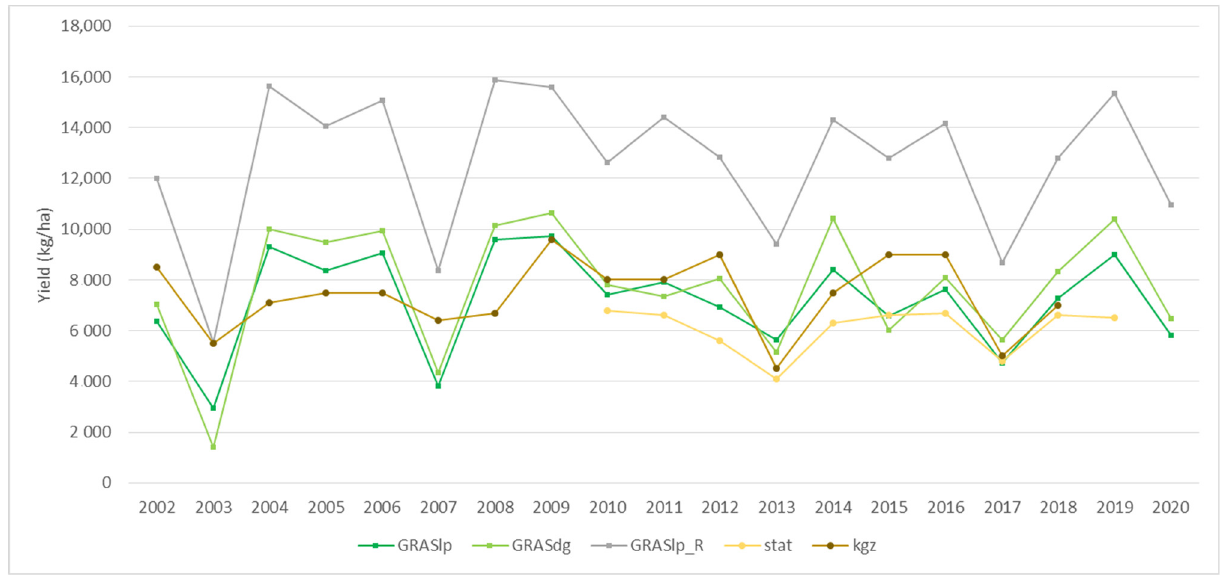
Figure 5. Model results of annual grassland yield for Farm2 using the parameter set calibrated for Dactylis glomerata and Lolium perenne in Jablje (GRASdg and GRASlp), Lolium perenne in Raki č an (GRASlp_R); annual grassland yield from SURS (stat), and annual yield based on the KGZ MB agricultural advisors’ observations (kgz).